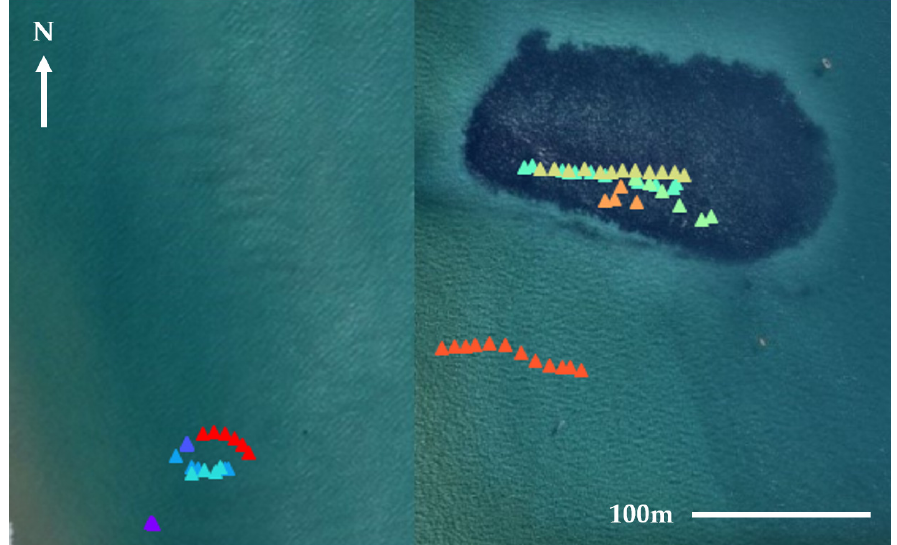
Figure 6. Map of GPS surfer tracks, with different colours showing different tracks. The aerial image is split from 2 days (neither close to the 13 January 2021) to ensure a bland background to plot tracks in the nearshore region, while still allowing visual verification on the reef. Therefore, sand bars visible in the aerial image should be ignored with respect to the tracks.